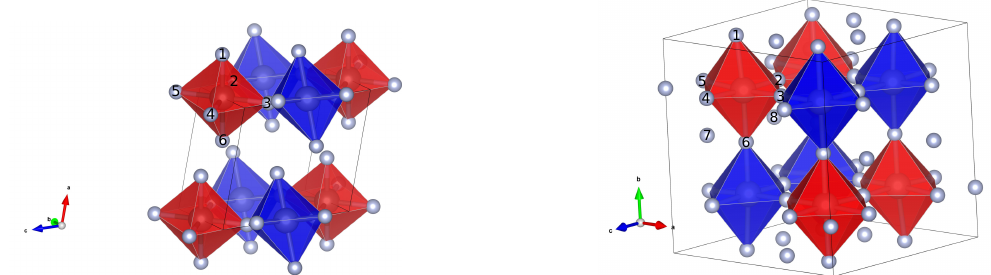
Figure 1. Structures of the most stable structure I derived from RuF 4 ( left ) and the structure of V (derived from ZrF 4 ( right )), both shown with octahedra. The blue and red colors represent the opposite orientations of magnetic moments on the Ni centers.